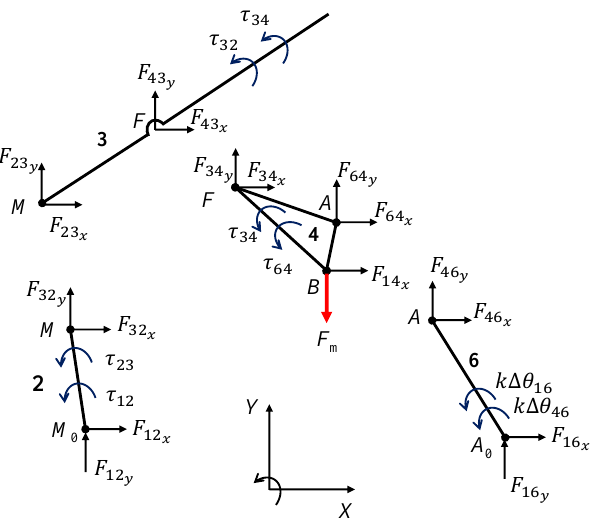
Figure 11. Illustration of the forces acting on the PRBM in a deformed position.